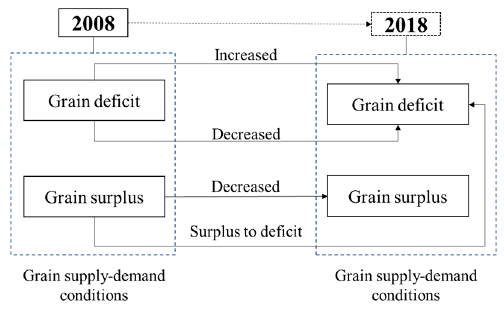
Figure 1. Four types of grain insecurity based on variations in grain supply-demand conditions from 2008 to 2018.